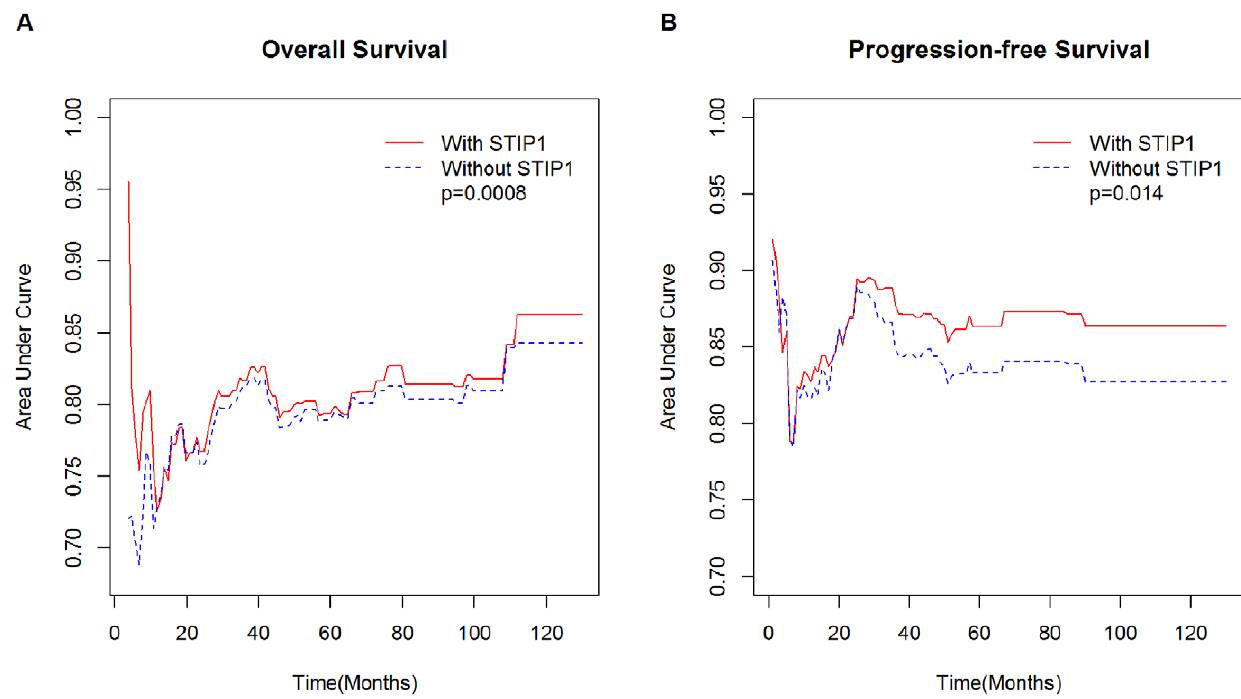
Figure 3. The addition of STIP1 histoscores improves the prediction of patients’ outcomes. The time-dependent AUC (area under the ROC curve) of the model including STIP1 is reported as a red solid line, whereas the AUC of the model without STIP1 is shown as a blue dotted line. Other parameters included stage, type, serum CA125, and residual disease. (A) Overall survival, (B) Progression-free survival.